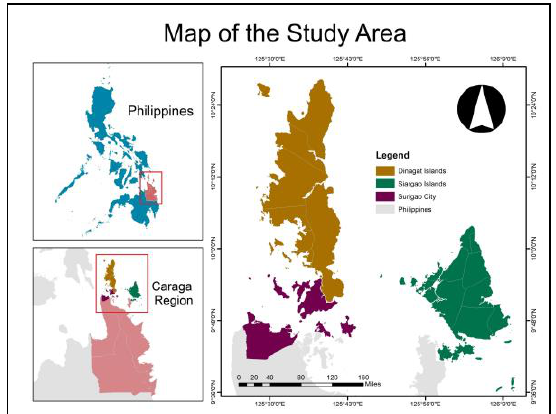
Figure 1 . Location map of Dinagat Islands, Surigao City and Siargao